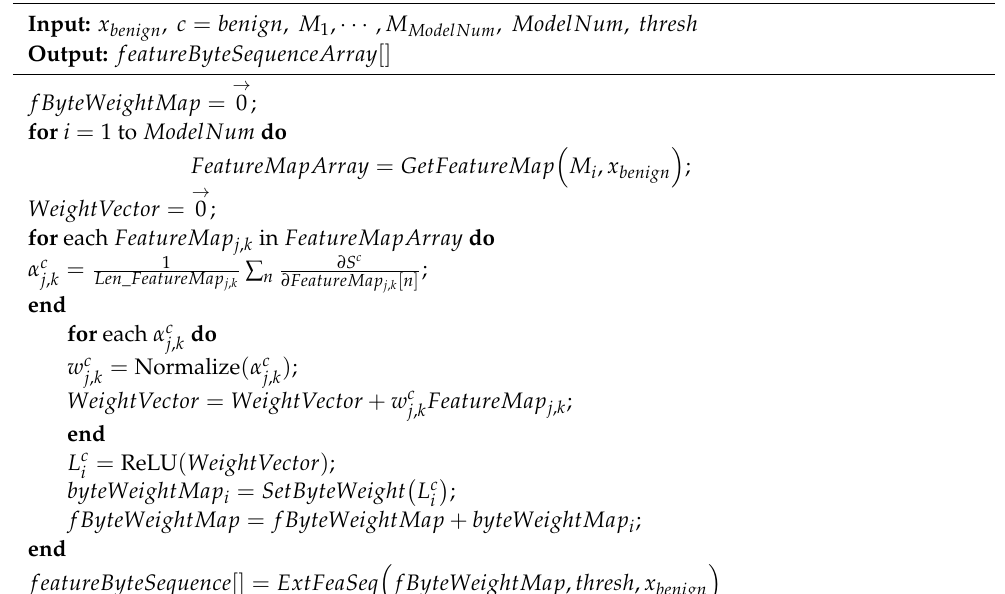
Figure 6. Extracting feature byte sequences. Algorithm 1: Extracting feature byte sequences of a benign